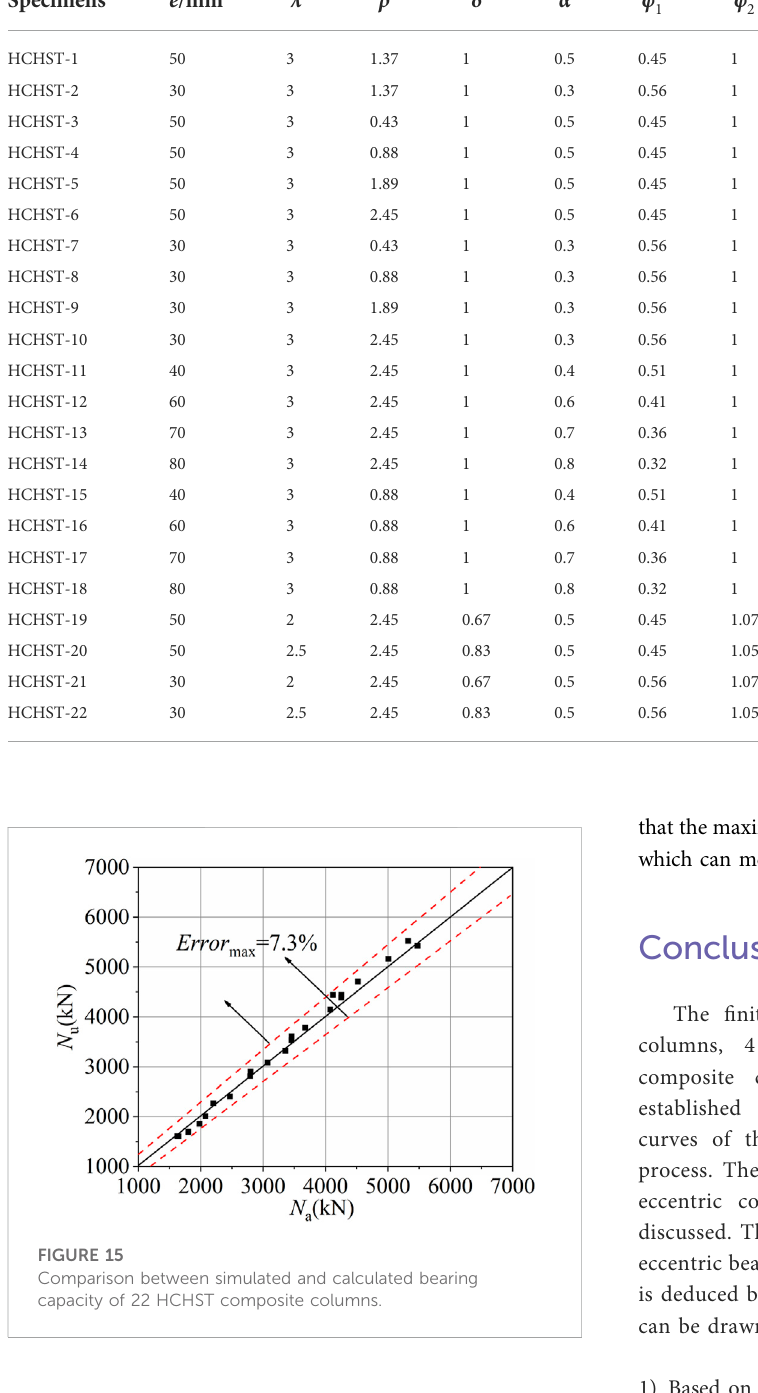
TABLE 4 Comparison between N a and N u for 22 high-performance concrete- fi lled high-strength steel tube composite columns. Specimens